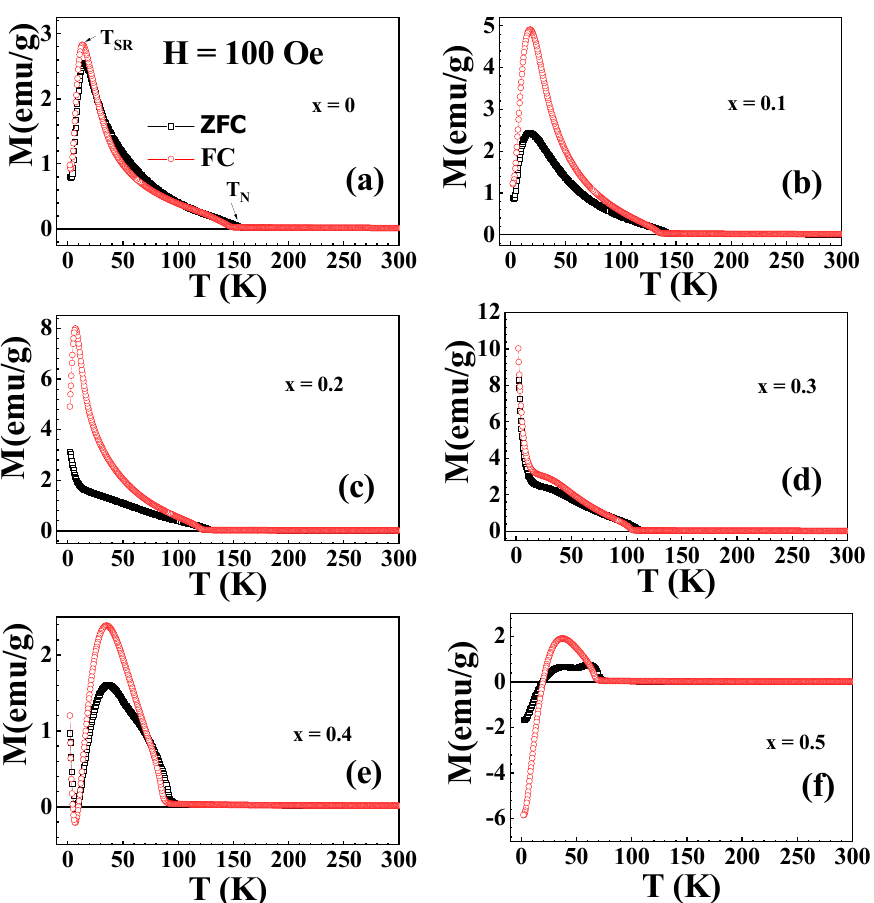
Figure 4. ( a – f ): ZFC and FC magnetization curves of GECMO series measured under 100 Oe magnetic field.